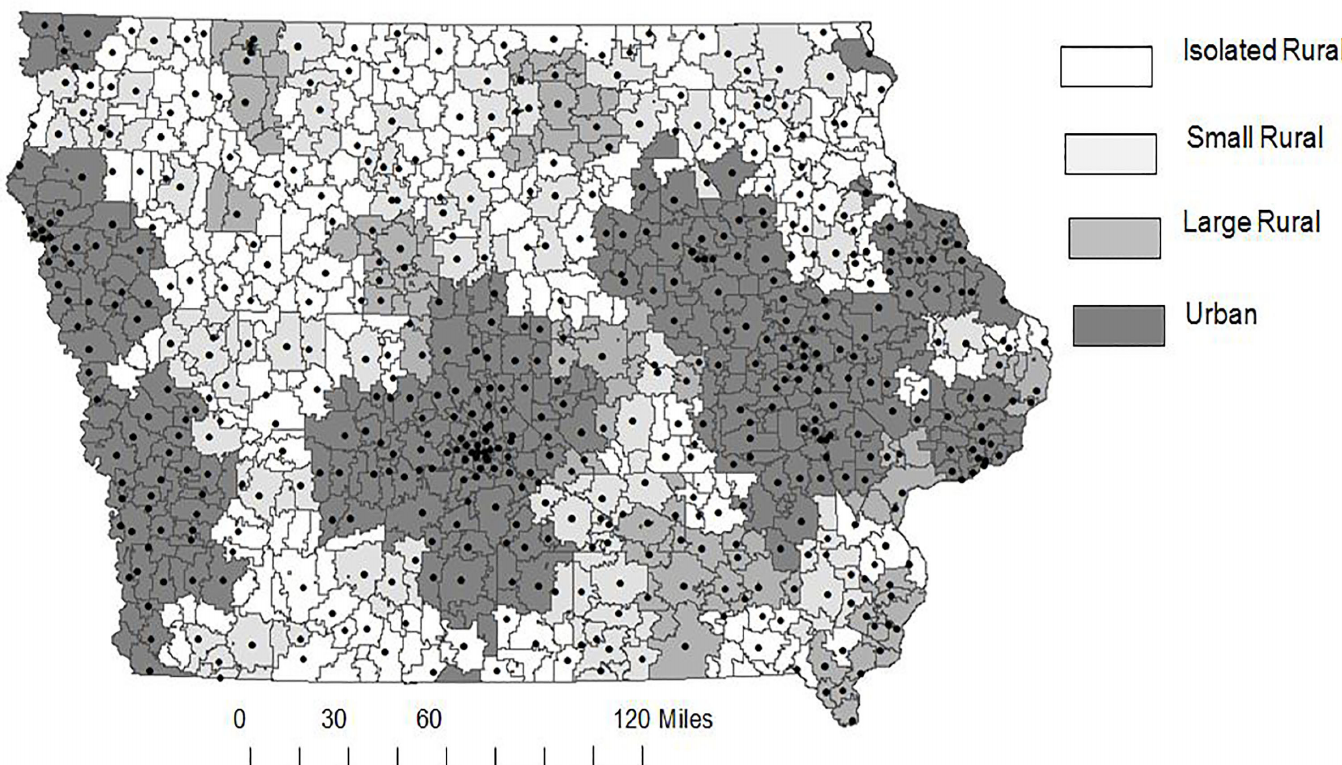
Figure 1. Zip code pattern of all-terrain vehicle (ATV) crashes in Iowa recorded in the Off-Road Vehicle Crash and Injury Database for the years 2002-2013 (n=1,832 crashes). Map shows zip code location of crashes with shading based on the Rural Urban Commuting Area (RUCA) coding